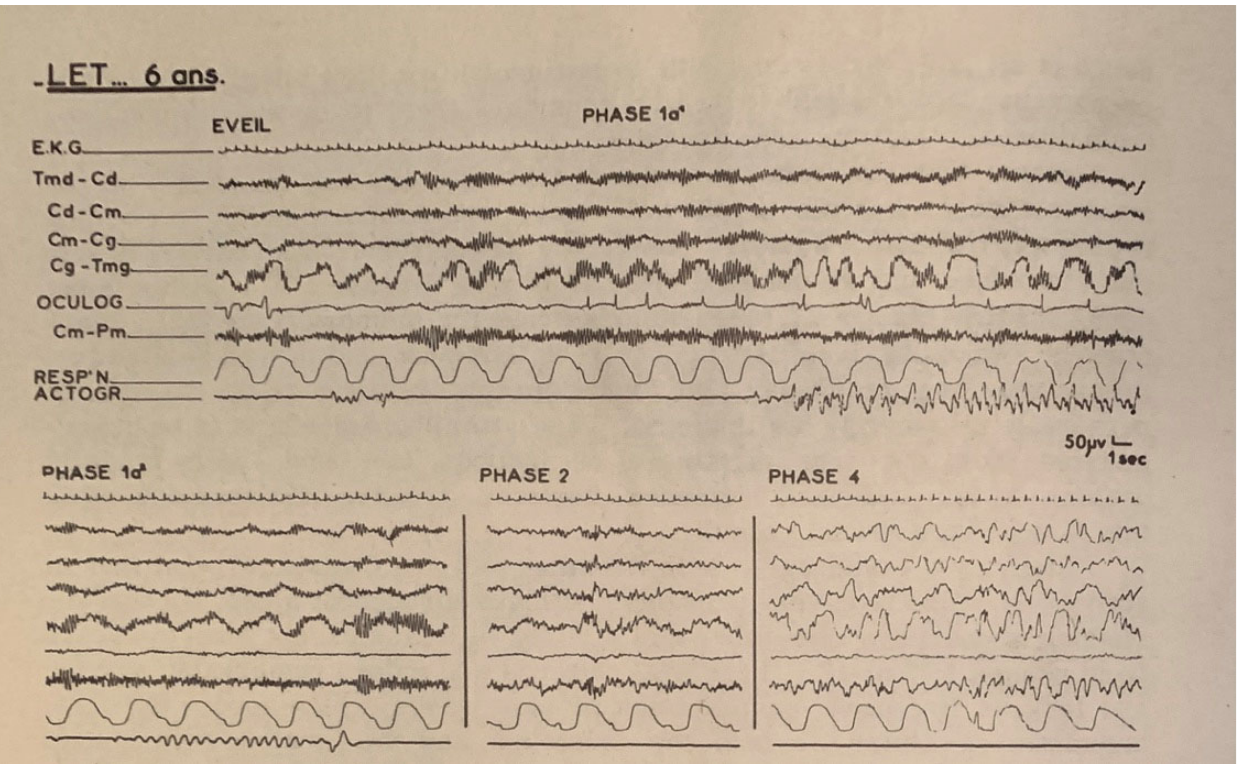
Figure 21. An episode of jactatio capitis nocturna in a 6 ‐ year ‐ old boy. The movements consist mainly of repeated head movements which are picked up by the actogram. Some respiratory movement artifacts are also recorded by the mid ‐ temporal electrodes. (Adapted from Gastaut, H. and Broughton, R.: A clinical and polygraphic study of episodic phenomena during sleep. Academic Address, in: Wortis, J. (Ed.), Recent Advances in Biological Psychiatry, New York, Plenum Press, 1965, pp. 197–221).).